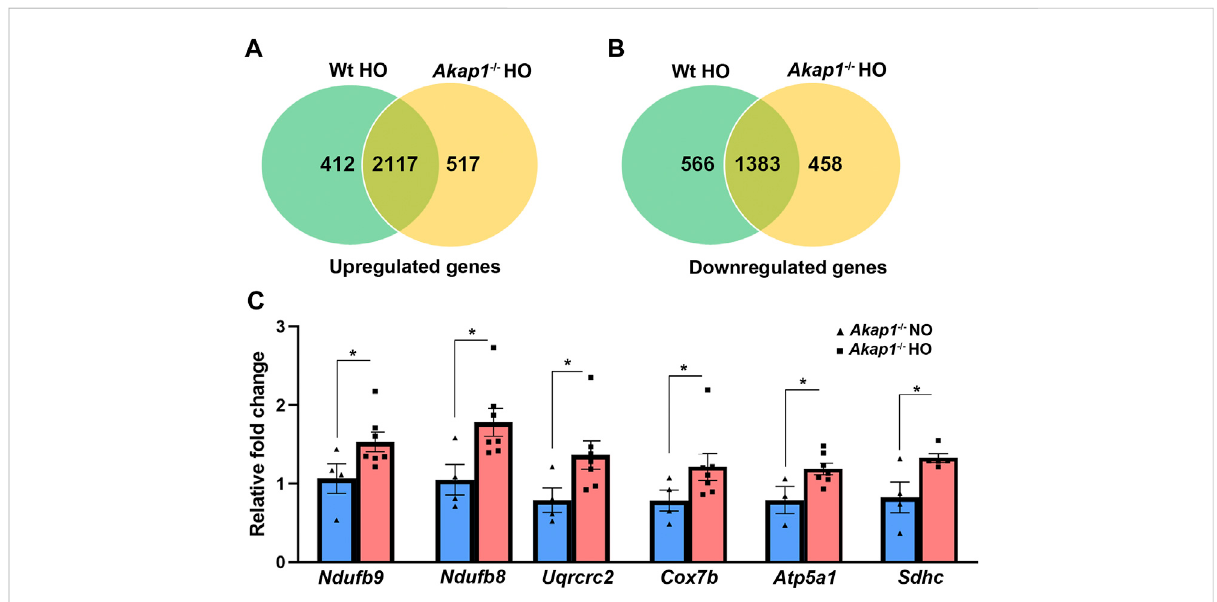
FIGURE 1 Differentially expressed genes in Akap1 − / − and Wt mice exposed to hyperoxia. (A) Venn diagram depicts upregulated genes unique and commonly shared between the Wt hyperoxia group and Akap1 − / − hyperoxia group and (B) Venn diagram depicts downregulated genes unique and commonlysharedbetween the Wt hyperoxiagroupand Akap1 − / − hyperoxiagroup,respectively. (C) qRT-PCRanalysis oftranscripts(ETCandTCA)in the Akap1 − / − hyperoxiagrouprelativeto Akap1 − / − normoxiagroup( n